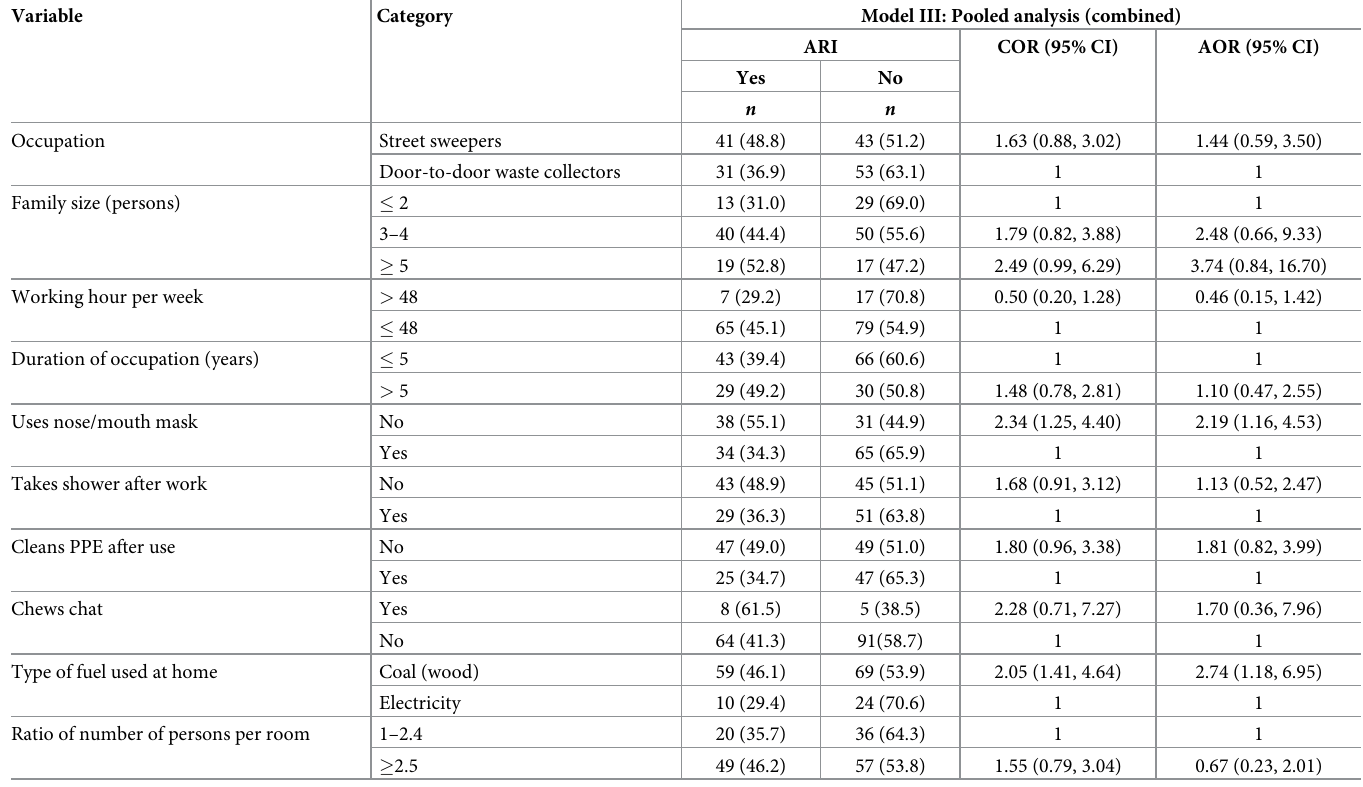
Table 8. Factors associated with ARI among both street sweepers and door-to-door waste collectors from pooled analysis of the multivariable logistic regression analysis in Dessie City, Ethiopia, March to May